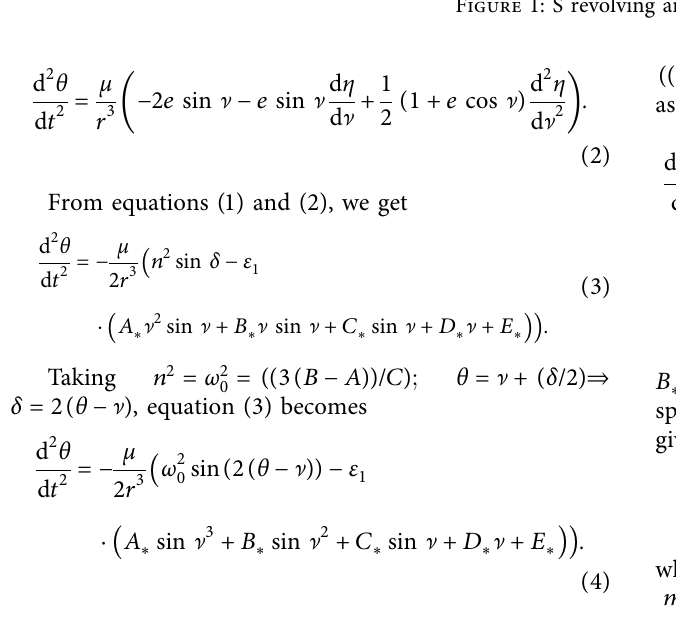
Figure 1: S revolving around Earth